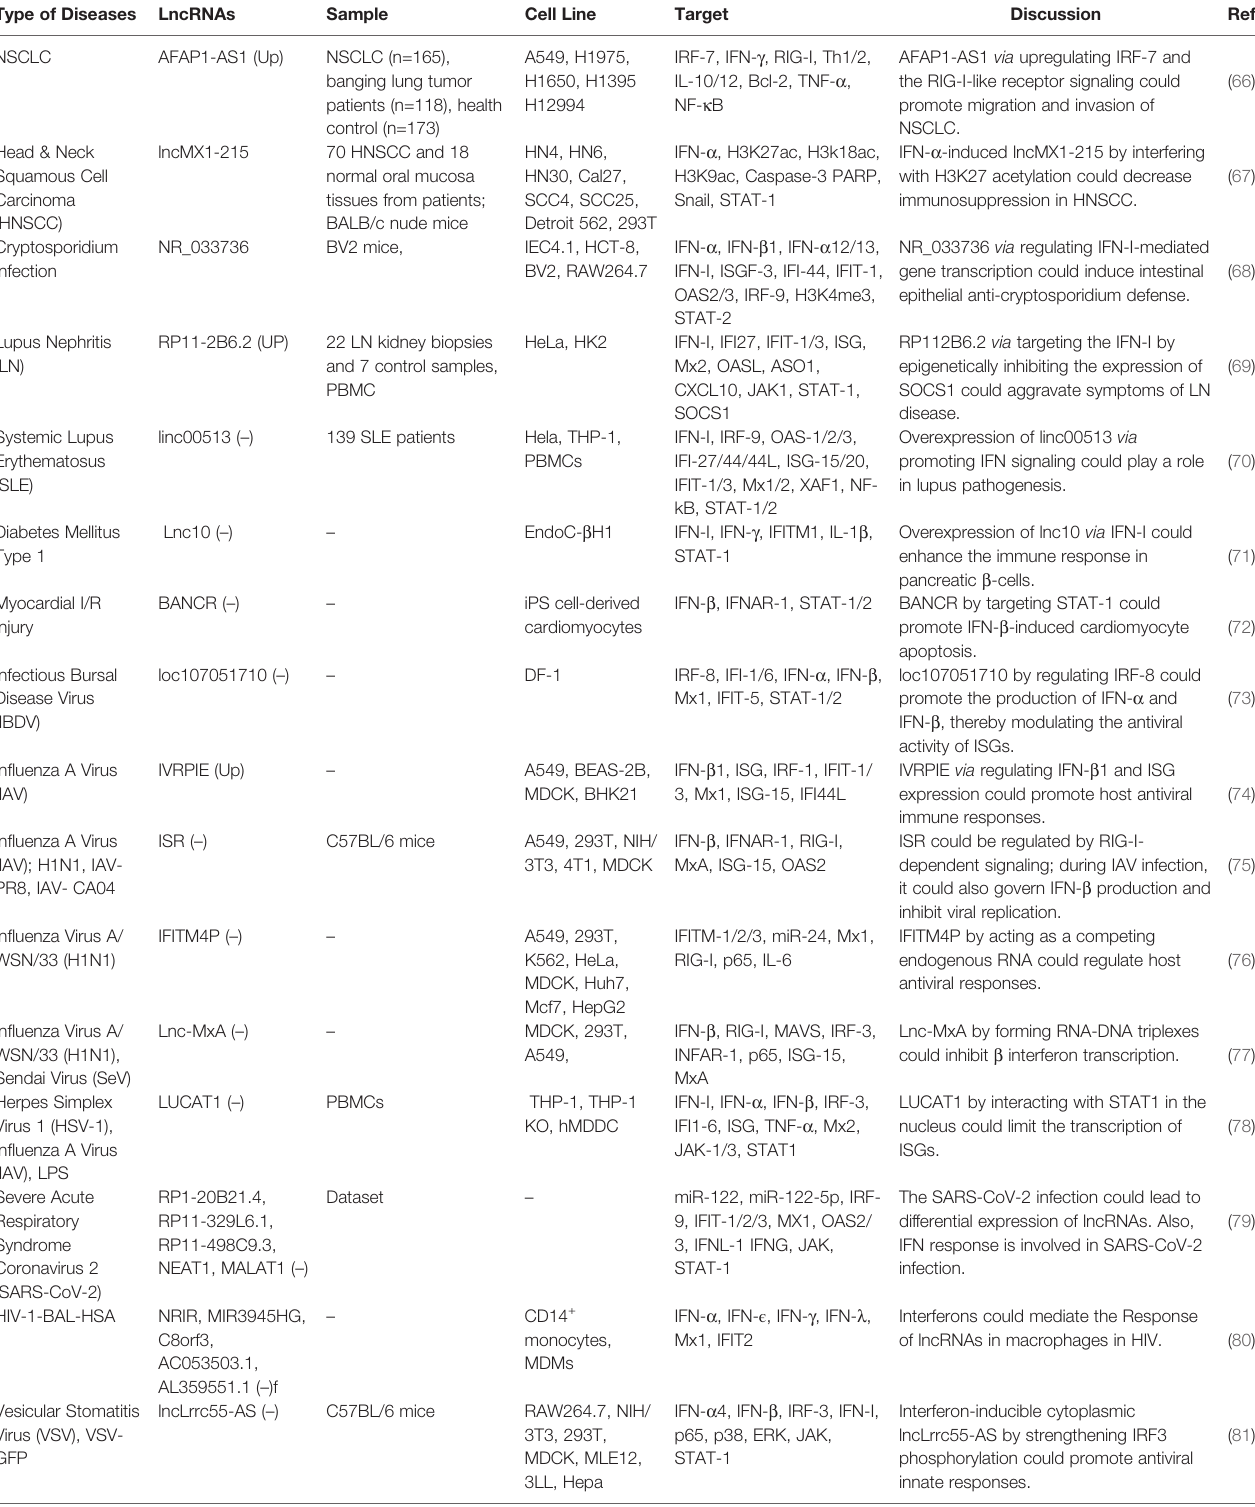
TABLE 3 | Interactions between lncRNAs and